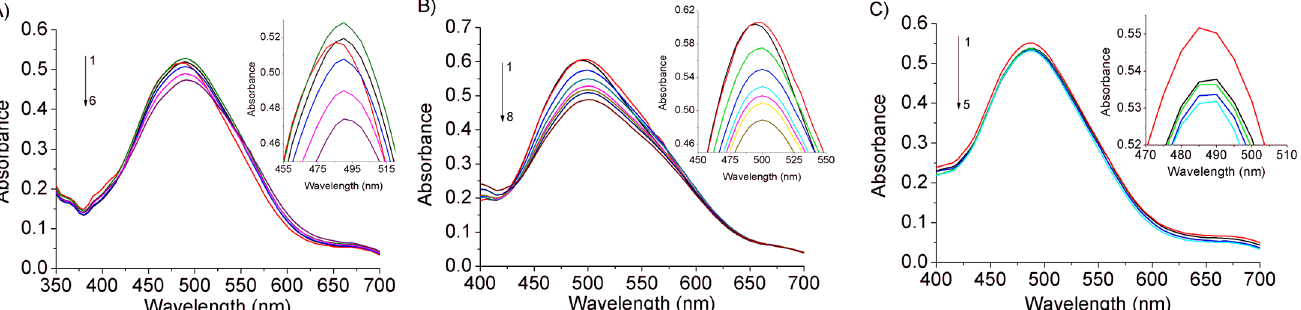
Fig 3. Interaction of the isophorone derivatives in presence of ds -DNA. UV-Vis absorption spectra of: A) Isoa (7.5 μ M) treated with: 0.0, 1.5, 3.0, 6.0, 7.5, 10.5 μ M (curves 1 – 6) of DNA. B) Isob (7.5 μ M) treated with: 0.0, 1.5, 3.0, 4.5, 6.0, 7.5, 9.0 13.5 μ M (curves 1 – 8) of DNA. C) Isoc (7.5 μ M) treated with: 0.0, 1.5, 6.0, 7.5, 10.5 μ M (curves 1 – 5) of DNA. All the experiments were carried out at room temperature in sodium cacodylate trihydrate 1 mM (pH 7.25). Inset: Absorption spectra highlights of A) Isoa, B) Isob and C) Isoc with DNA.